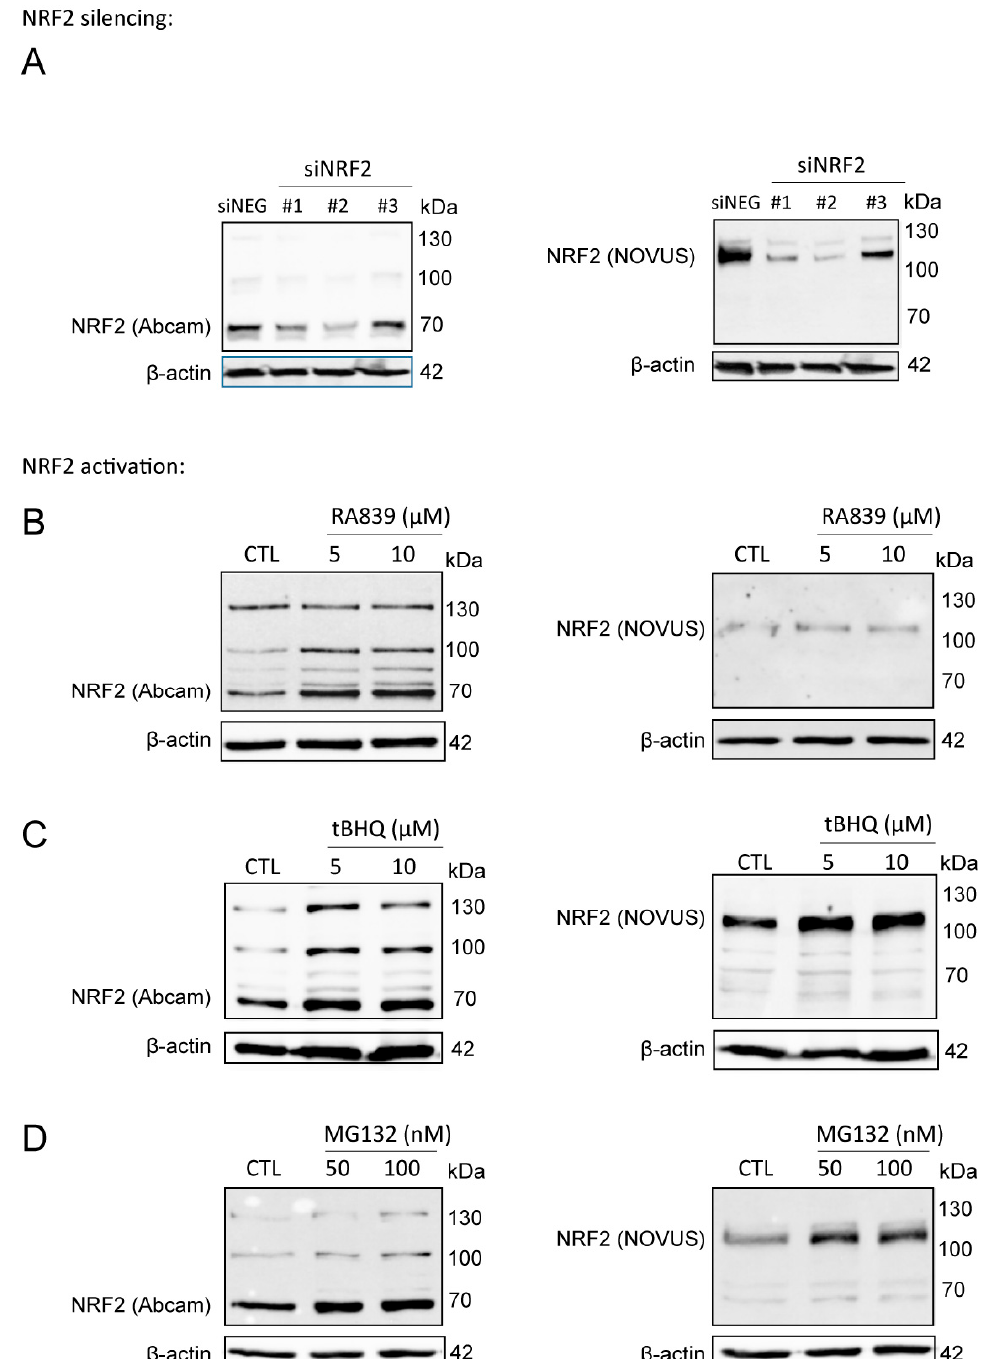
Figure 1. NRF2 antibody validation. ( A ) NRF2 expression was silenced in MCF7 cells by transiently transfecting NRF2-specific siRNAs or a negative control siRNA for 48 h, then NRF2 protein expression was determined using two different antibodies (Abcam: ab31163; NOVUS: NBP1-32822). ( B – D ) 4T1 cells were treated with NRF2 activators, RA839 or tBHQ, or MG-132, a proteasome inhibitor, in the concentrations indicated for 48 h, then NRF2 protein expression was determined by western blotting using two different antibodies (Abcam: ab31163; NOVUS: NBP1-32822).